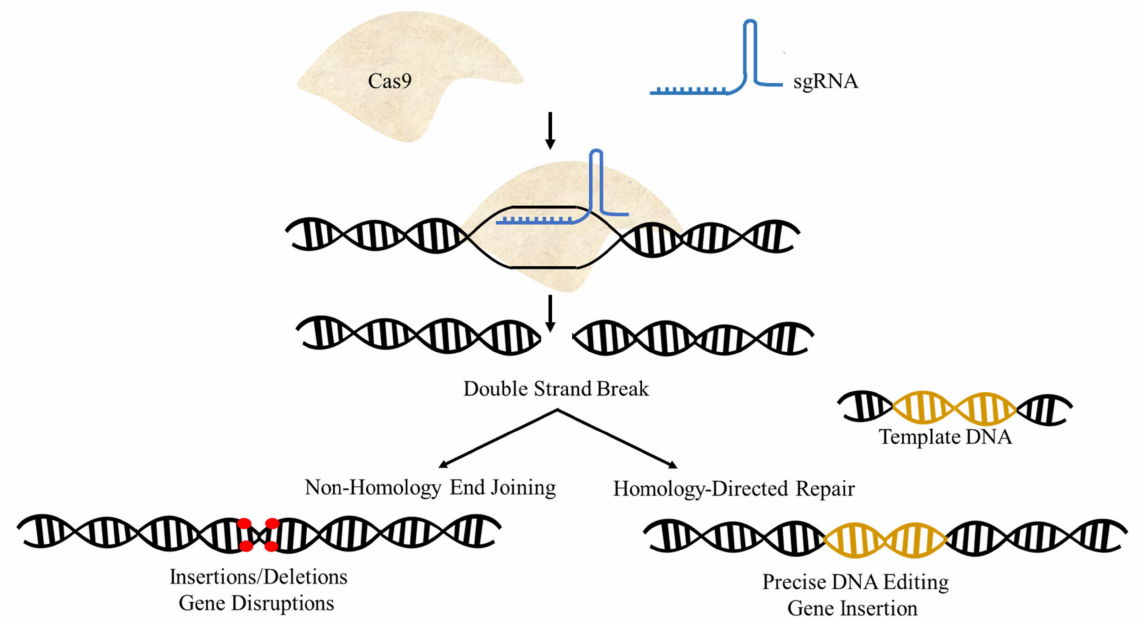
Figure 1. Schematic diagram of CRISPR/Cas9 mechanism. The system consists of Cas9 enzyme and gRNA, which bind with targeted double-stranded DNA to induce DSBs with blunt ends. The break can be repaired by either NHEJ or HDR. HDR requires a template, but NHEJ does not. Both mechanisms result in gene disruptions, deletions, and DNA editing containing the Cas9 gene and gRNA to the host genome at a random